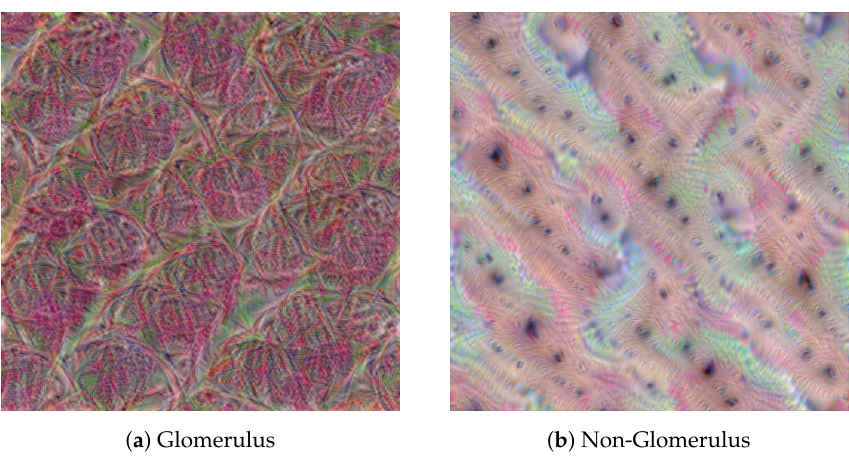
Figure 13. DeepDream concept class visualization for pre-trained